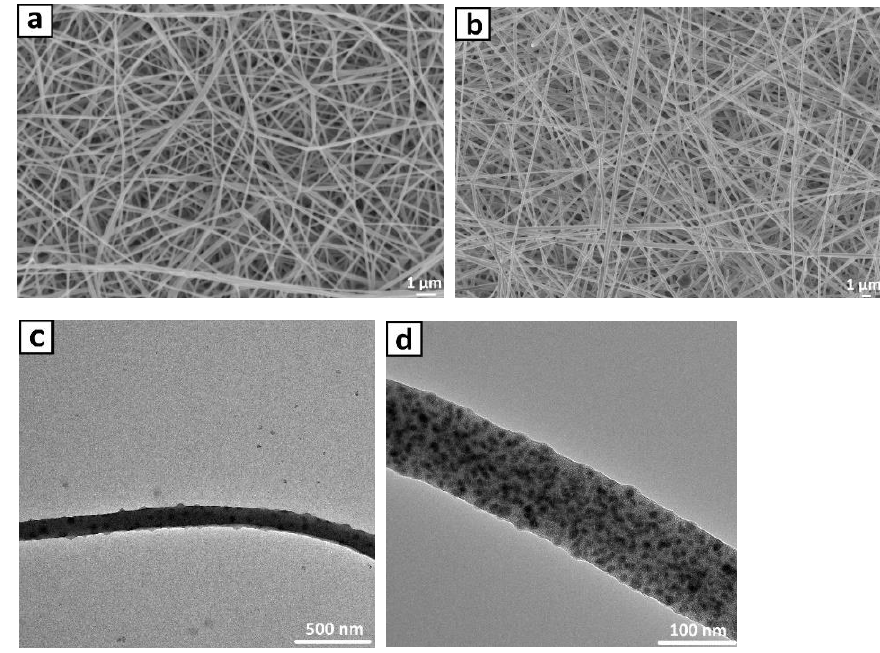
Figure 5. ( a ) SEM images of CNF and ( b ) CNF/GLC composite and ( c , d ) TEM images of CNF/GLC composite .